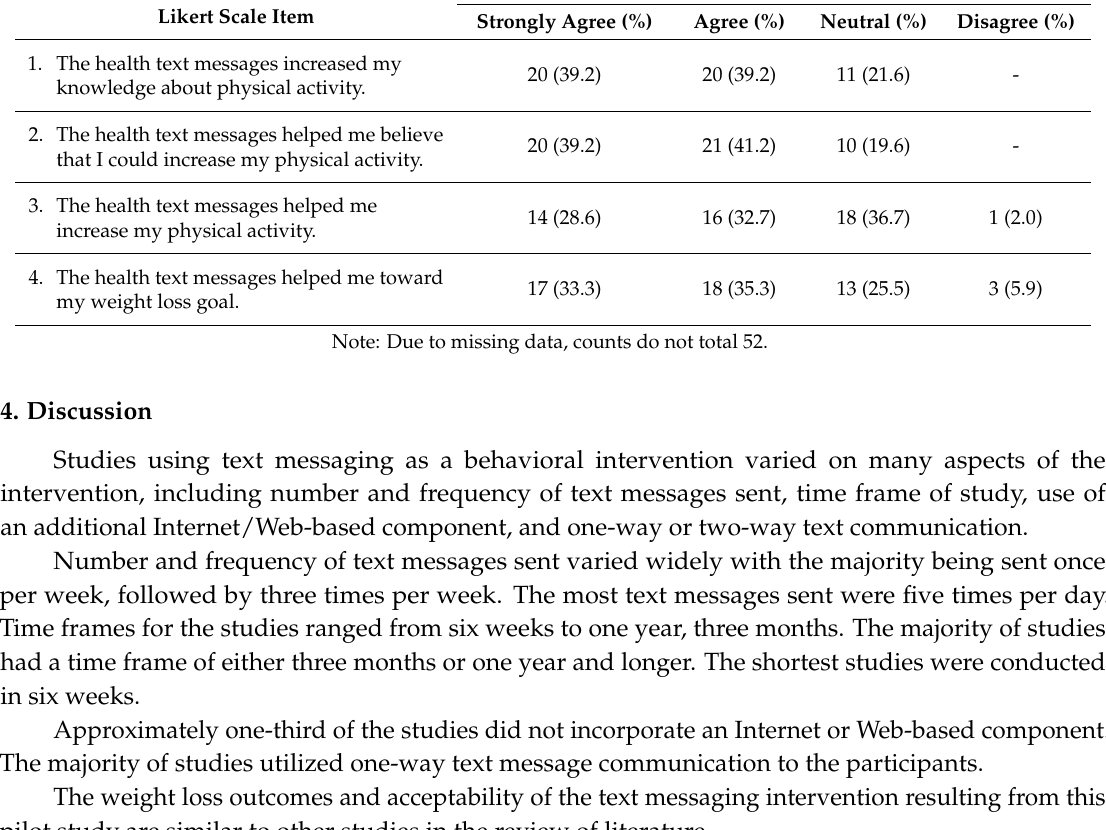
Table 4. What effect will the health text messages have on knowledge, beliefs and behaviors of intervention group participants regarding physical activity options, and thus their weight loss goal? Intervention Group n = Likert Scale Item